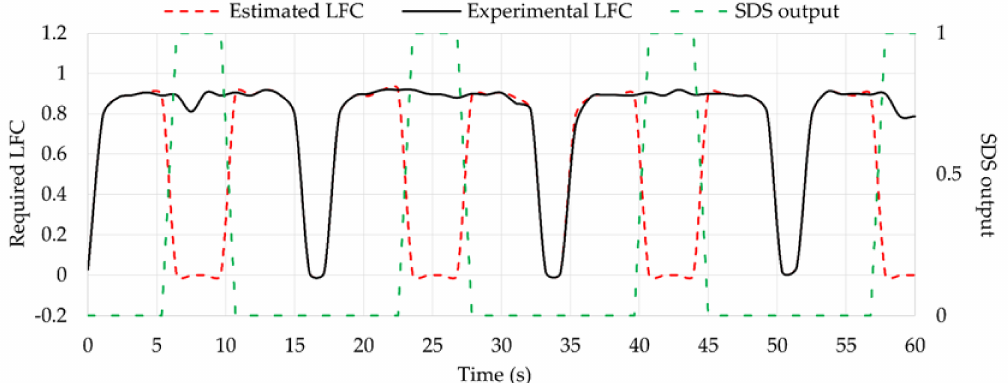
Figure 21. Estimated LFC compared to theoretical